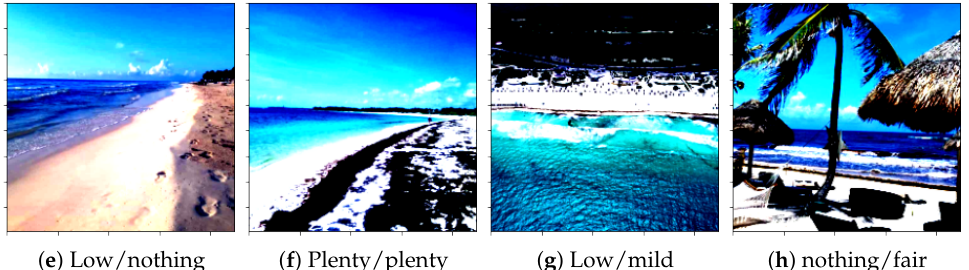
Figure 4. Examples of Sargassum level classification using the selected convolutional neural network. Displayed images are already pre-processed: normalization and resize. The label for each example indicates: ‘predicted label/true